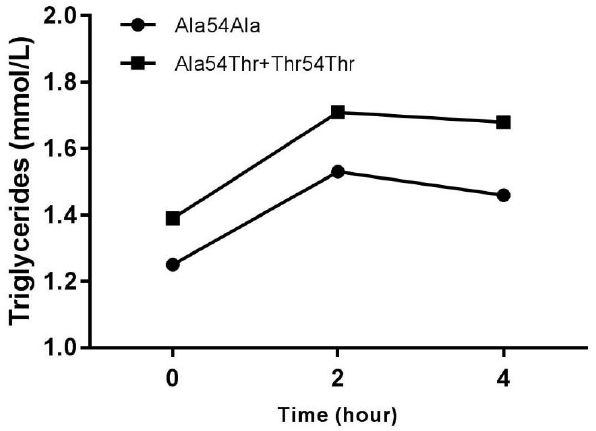
Figure 2. Effect of FABP2 Ala54Thr polymorphism on triglycerides (mmol/L) after OFTT.